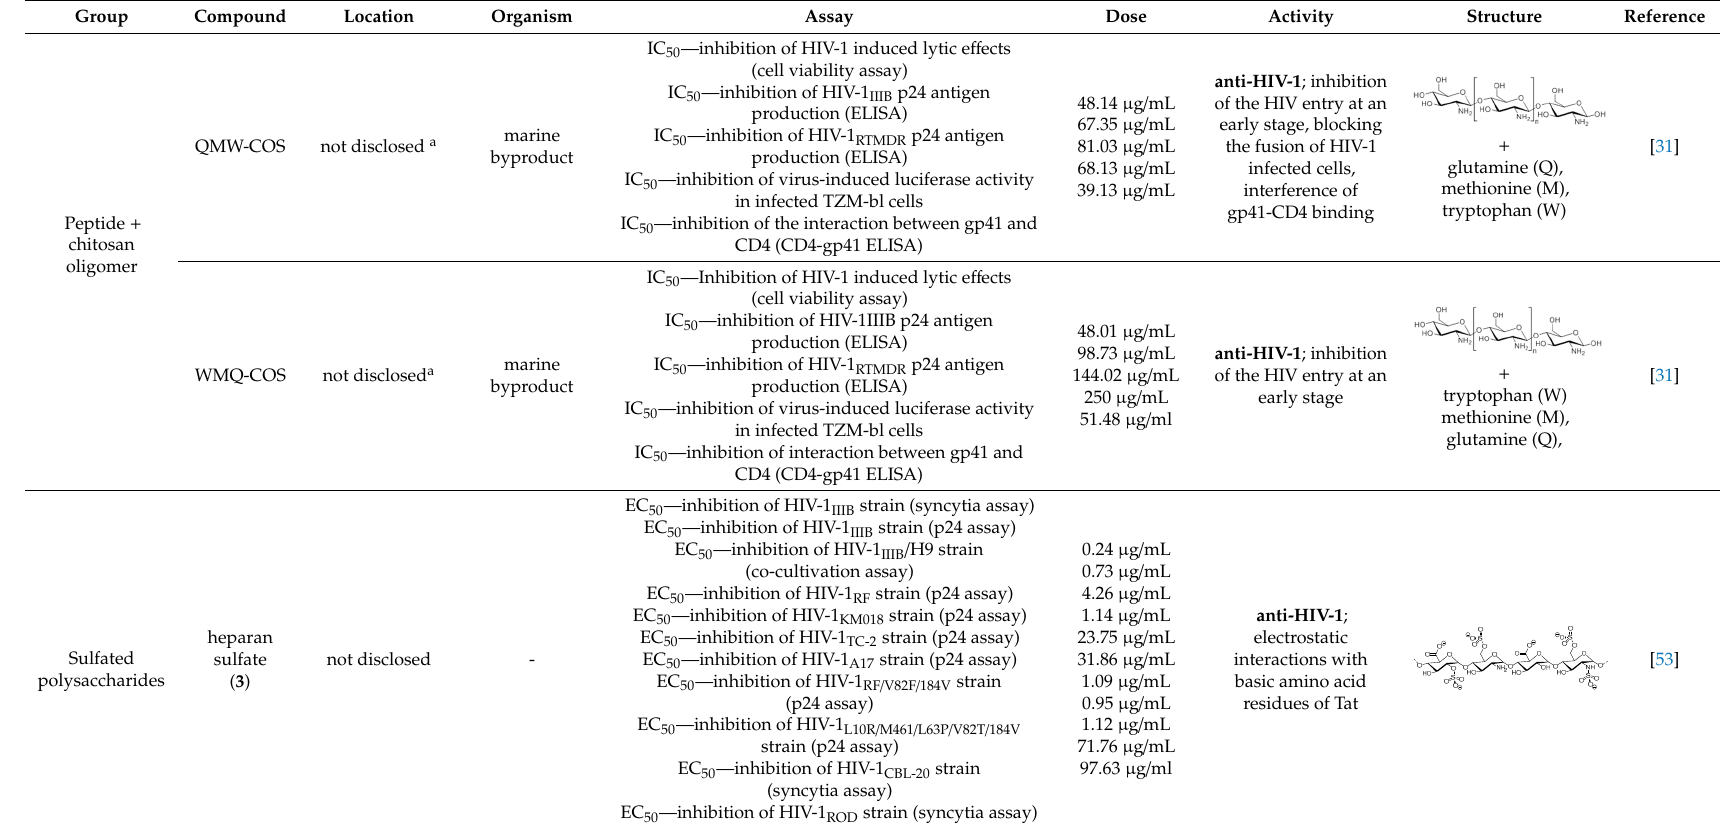
Table 3. Summary of anti-HIV compounds from marine organisms.